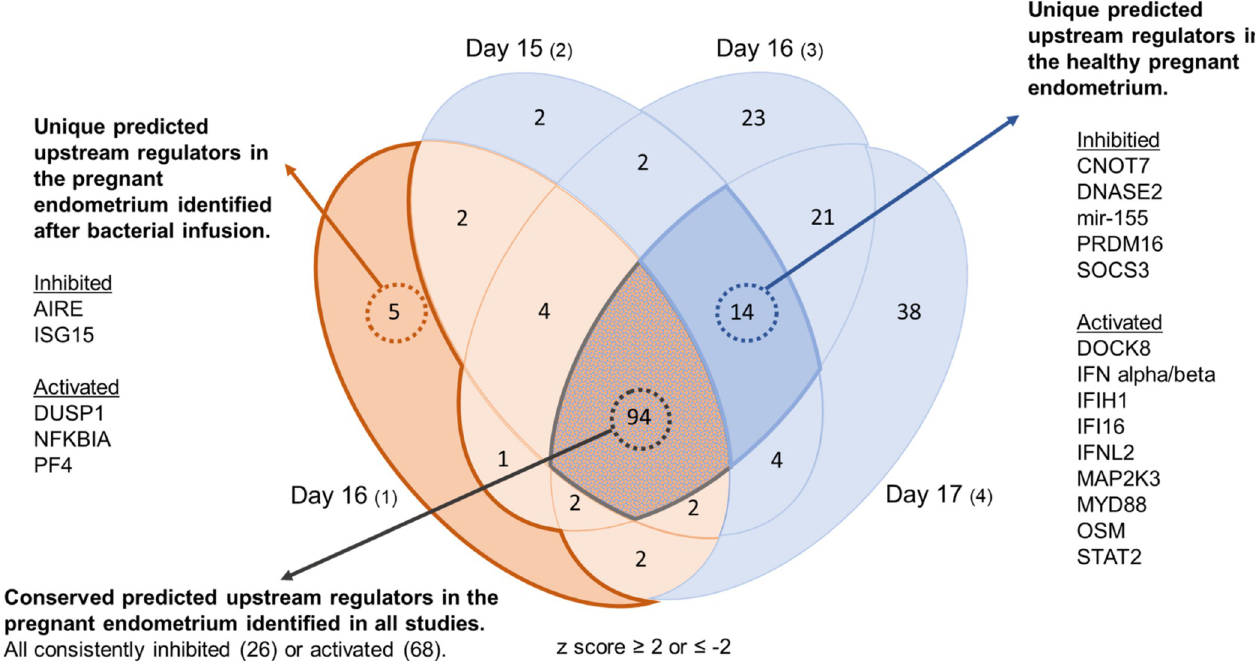
Fig 5. Pregnancy regulated predicted upstream regulators in the endometrium of healthy cows and cows following intrauterine infection of bacteria.